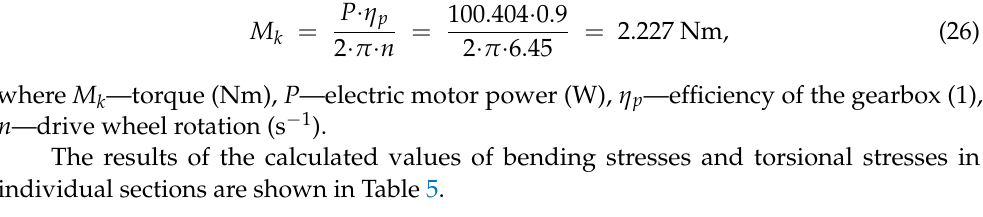
Table 5. Calculated values of the bending stresses and torsional stresses in the individual